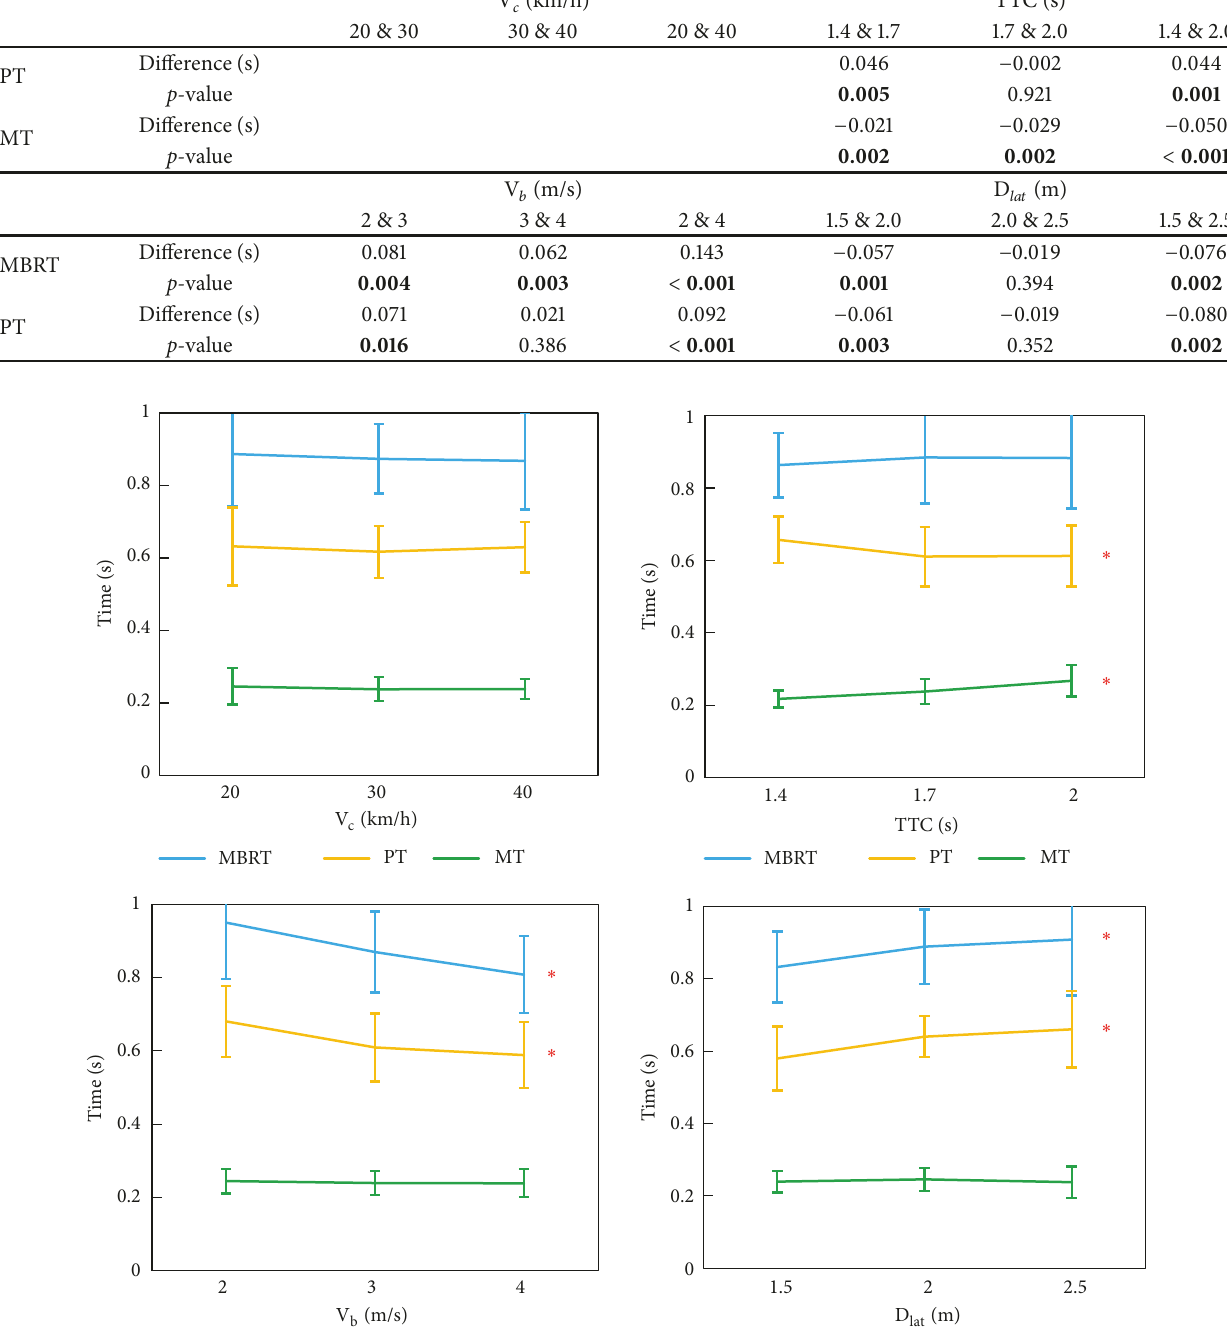
Figure 5: The average ( ± SD) of MBRT, PT, and MT at three levels of the four parameters in